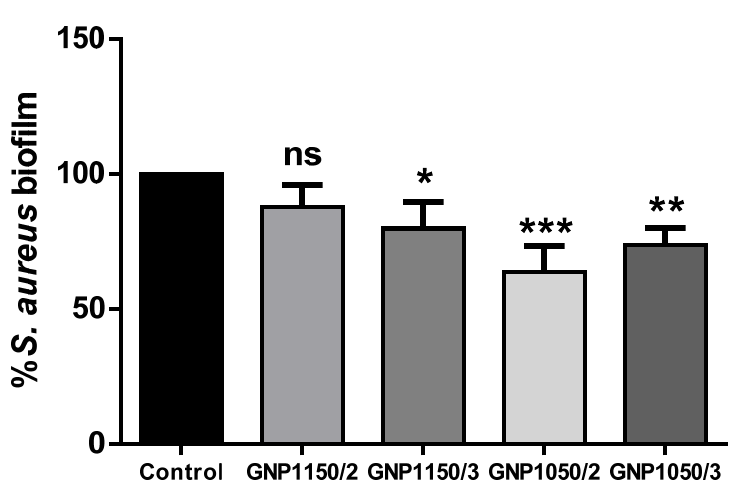
Figure 5. Biofilm formation was analyzed by the crystal violet binding assay in S. aureus cells. The production of bacterial biomass was evaluated. The production of bacterial biomass was evaluated for each of the four groups of Ti-disks coated by GNPs, and expressed as biofilm formation relative to uncoated Ti-disk samples (control group). Statistical significance: * p < 0.05, ** p < 0.01, *** p < 0.001, and ns = not significant.